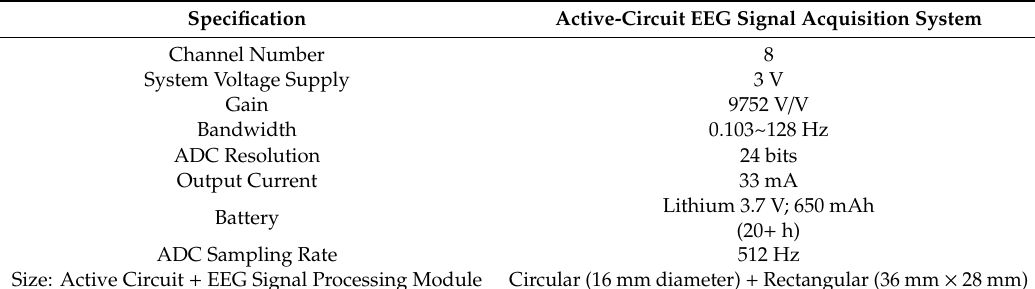
Table 1. Specifications of the electroencephalography (EEG) signal acquisition system.